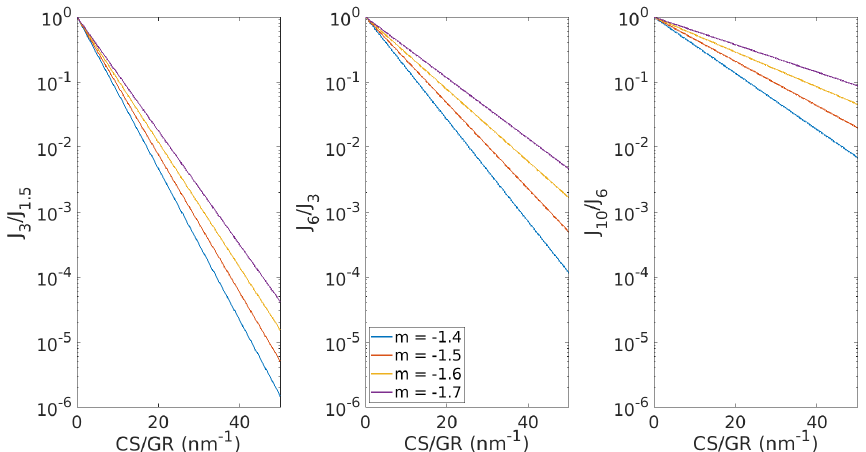
Figure 4. Predictions for the survival probabilities from 1.5 to 3nm ( J 3 /J 1 . 5 ), from 3 to 6nm ( J 6 /J 3 ), and from 6 to 10nm ( J 10 /J 6 ) according to the formulation by Lehtinen et al. (2007). Horizontal axis is the ratio of condensation sink and growth rate (CS / GR). Four different values for the parameter m have been used.